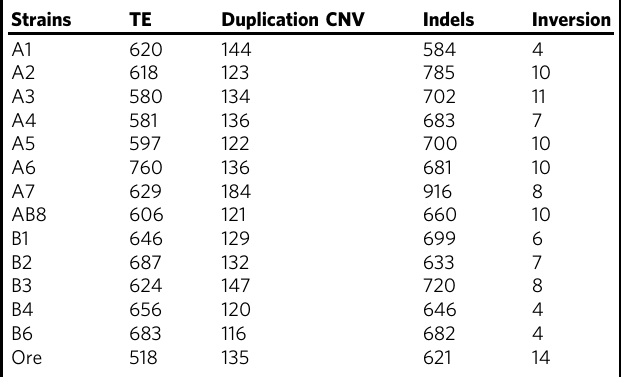
Table 1 Summary of assembly metrics